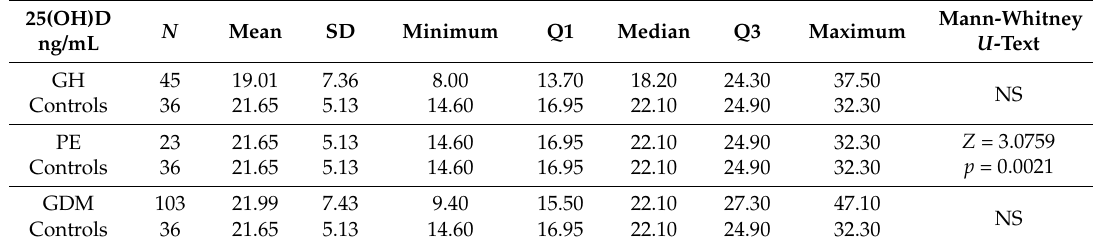
Table 2. Serum concentrations of 25(OH)D (ng/mL) in various subsets of patients (Q1—lower quartile;